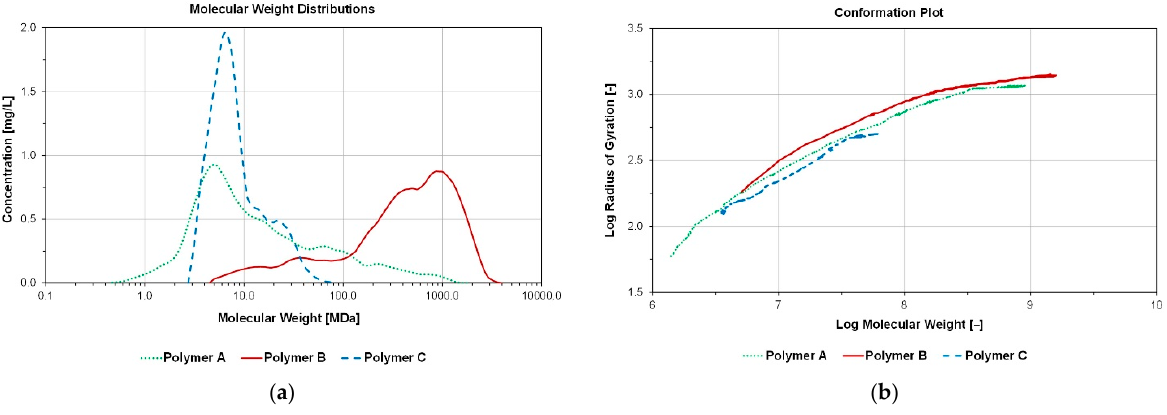
Figure 4. Molecular Weight Distributions ( a ) and conformation plot ( b ) of polymers A, B and C. Table 3. Calculated MWDs and gyration radii of polymers A, B and C.